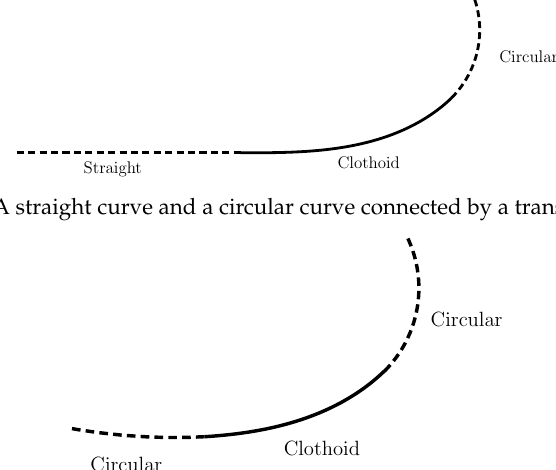
Figure 2. Two circular curves with different radius connected by a transition